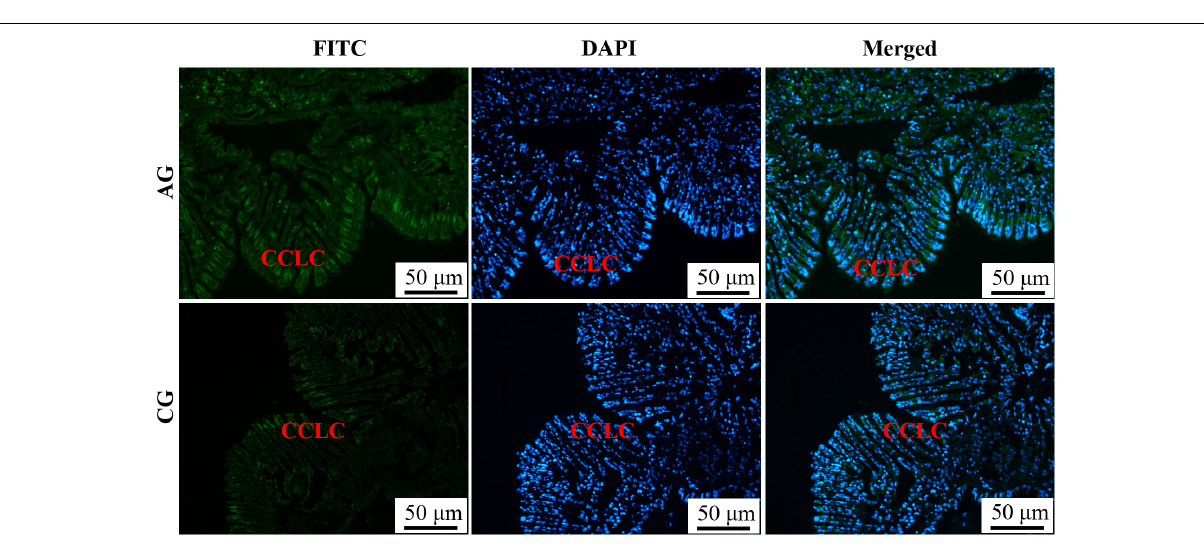
FIGURE 2 | Immunofluorescence of Glutamine synthetase gene from Sinonovacula constricta ( Sc-GS ) in the gills. Sc-GS protein was stained with the anti-GS antibody in green, and nuclei were stained with DAPI in blue. The merged images were colocalized with Sc-GS protein (green) and DAPI (blue) in the columnar cells of lateral cilia of gills. Scale bars were 50 µ